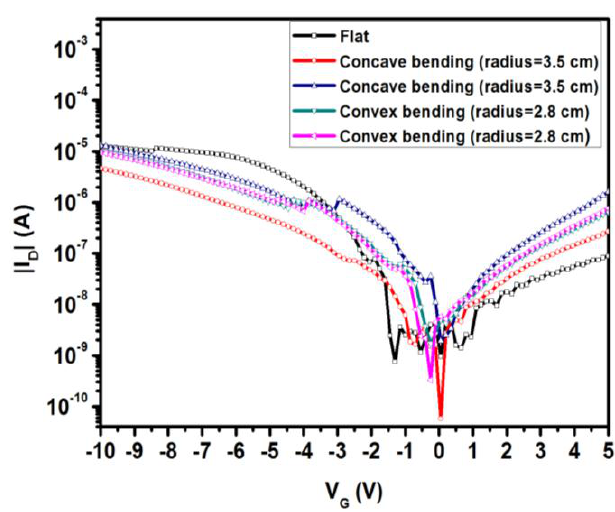
Figure 8. Comparison of the electrical characterization of the P3HT-based organic thin-film transistors (OTFTs) with a 0.023 wt % blended Y 2 O 3 /chitosan dielectric gate for bending tests at different bending radii and without bending. Table 2. Electrical characterization of the P3HT-based OTFTs with a 0.023 wt % blended Y 2 O 3 /chitosan dielectric gate on the polyimide substrate for bending tests.